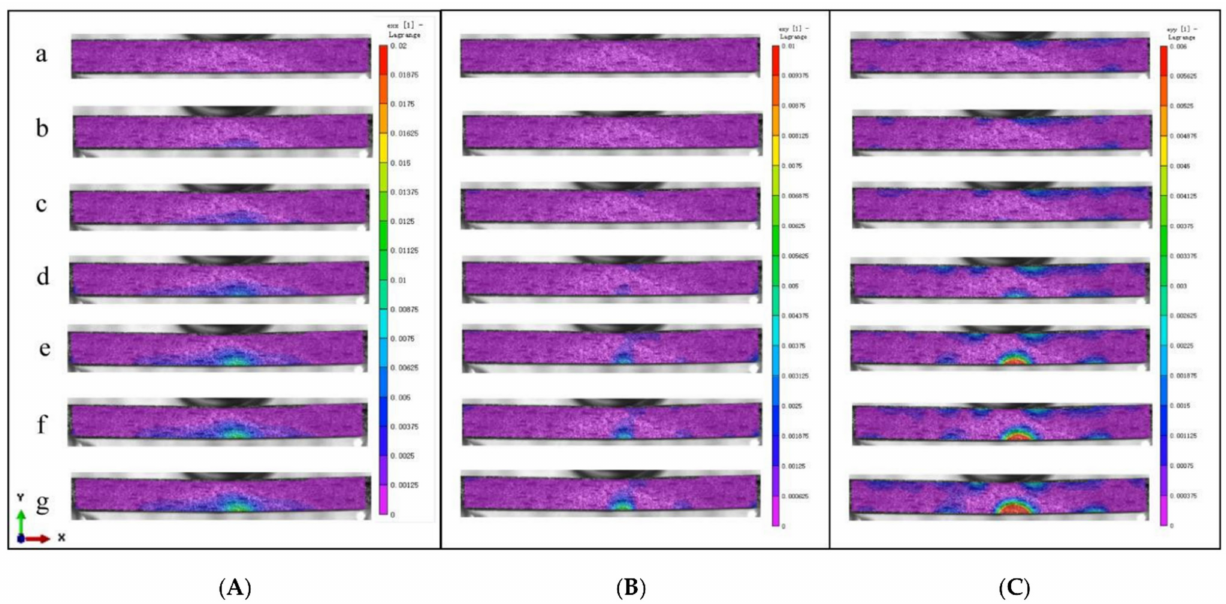
Figure 10. Evolution of the full-field strains under the forces of 135, 181, 227, 272, 323, 280, and 64 N: ( A ) ε xx , ( B ) ε yy , and ( C ) ε xy .